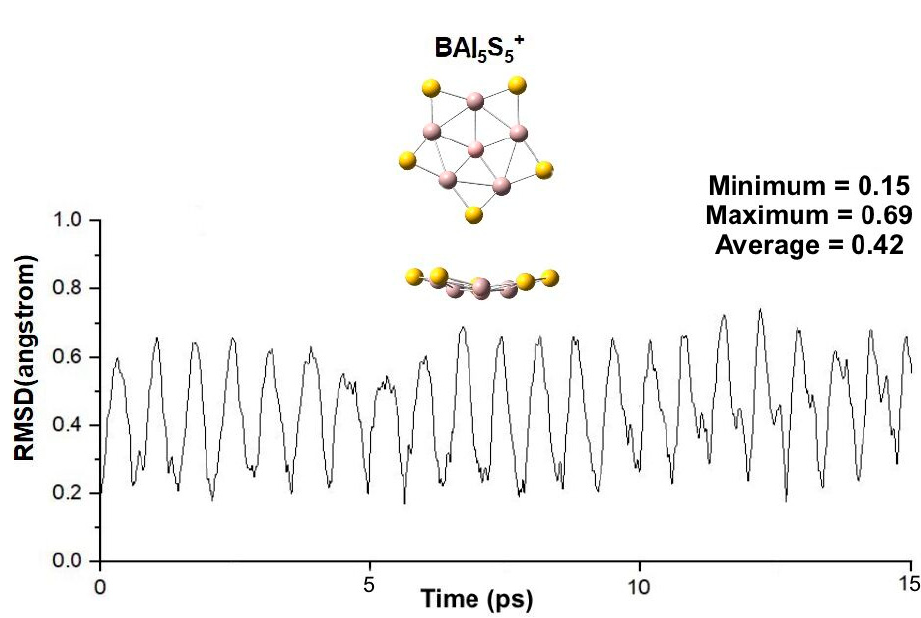
Figure 2. Root-mean-square deviations (RMSD) of BAl 5 S 5+ during Born–Oppenheimer molecular dynamics (BOMD) simulations at 900 K. The final snapshot of the structure is also shown here.